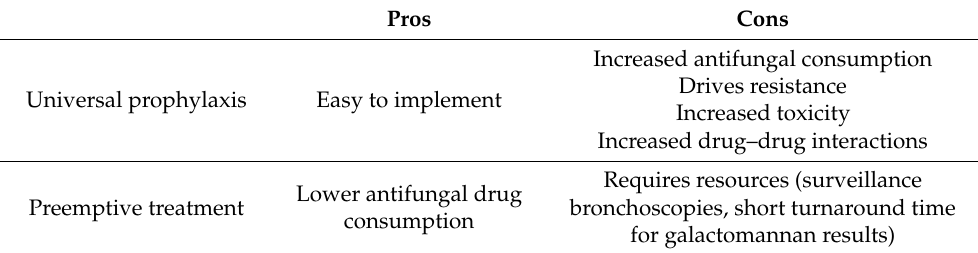
Table 3. Pros and cons of the different prevention